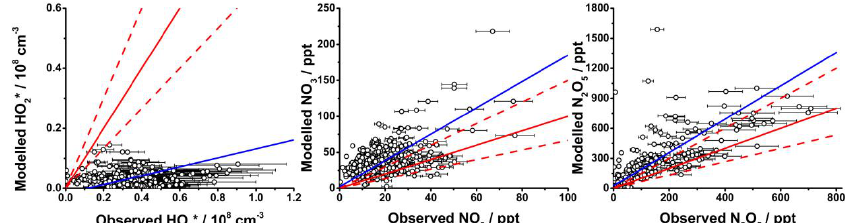
Figure 15: Comparison between modelled and observed concentrations of (a) HO 2 *, (b) NO 3 and (c) N 2 O 5 for a model run including summer and winter data in which alkene concentrations are set to zero. In each plot, the solid red line indicates the 1 : 1 line, with 50% limits given by the broken red lines. The best fit lines are shown in blue, and are described by [HO 2 *] mod = {(0.2 ± 0.1) × [HO 2 *] obs }– (1.8 ± 2.6) × 10 6 cm -3 ( r 2 < 0.01), [NO 3 ] mod = {(1.8 ± 0.2) × [NO 3 ] obs } + (2.1 ± 3.8) ppt ( r 2 = 0.3) and [N 2 O 5 ] mod = {(1.6 ± 0.1) × [N 2 O 5 ] mod } – (39.2 ± 22.2) ppt ( r 2 = 0.6). Error bars are the 1σ calibration uncertainties.